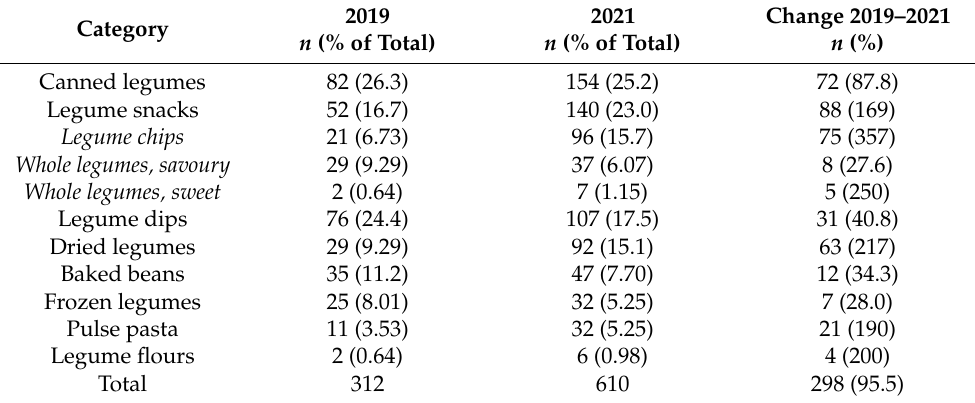
Table 2. The number of legume products identified per category and sub-category in both 2019 and 2021 and the change over